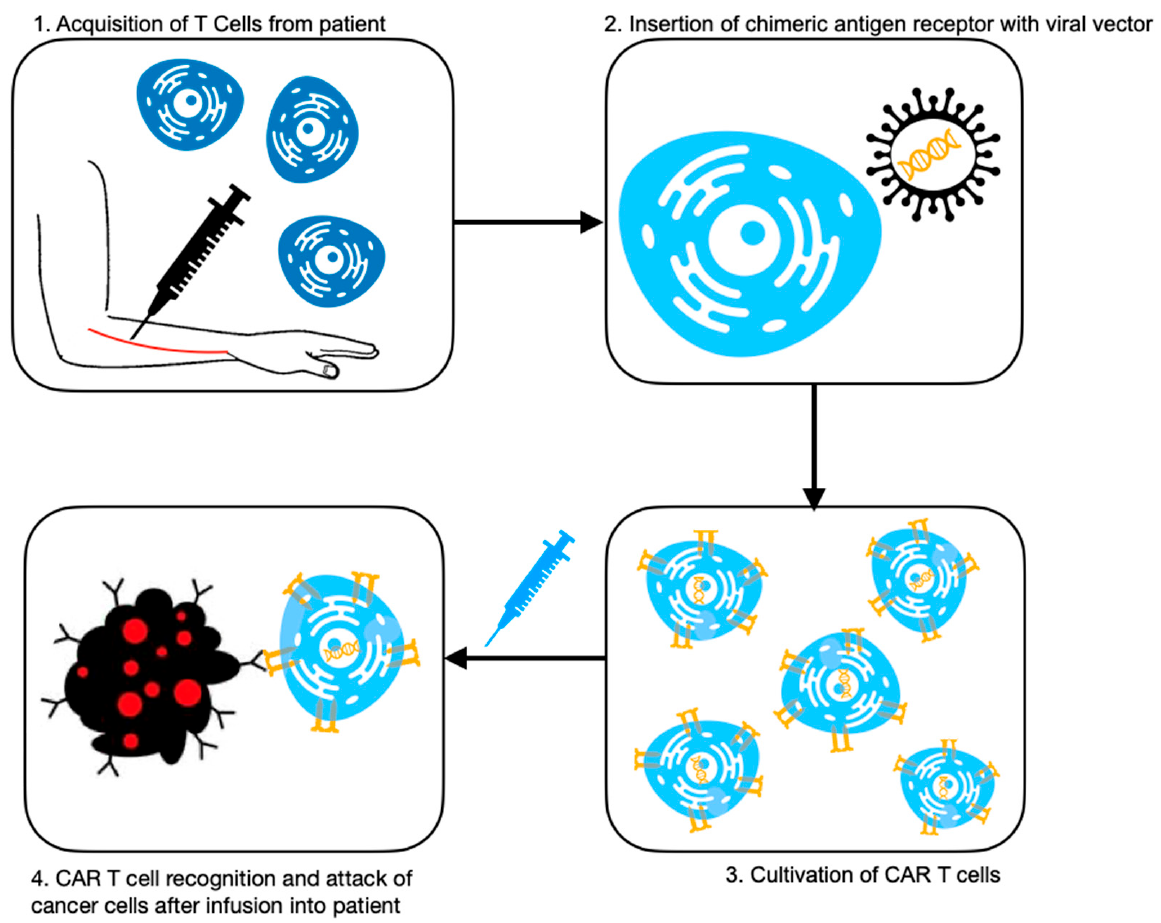
Figure 1. Summary of CAR T-cell therapy [23].